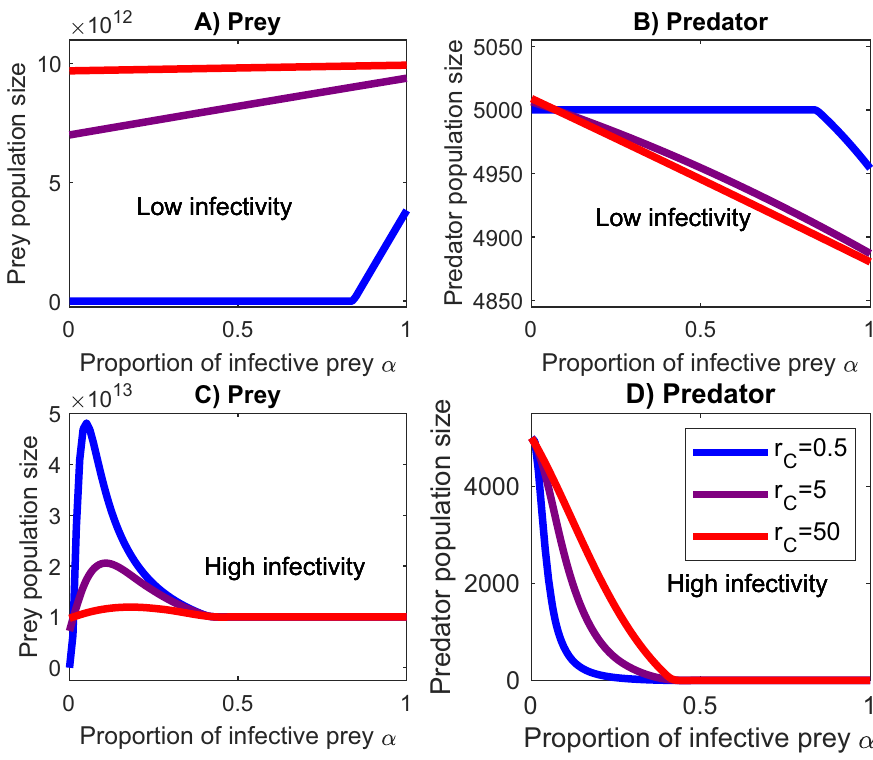
Fig 3. Proportion of infective prey α affects the population in the same way as infectivity e SI . (A) Slowly growing prey with low infectivity can proliferate only if the majority of the prey are infective. (B) Even high proportions of infective prey cause only a slight decrease in predator population. High infectivity e SI prevents the extinction of the prey. (C) Highly infective prey thrives best when it forms relatively small part of the prey population because (D) the predator becomes extinct if the majority of the prey are infective ( α ≳ 0.4). Red, purple and blue lines are fast (r C = 50), medium (r C = 5) and slow (r C = 0.5) growth rates. Infectivity values are e SI = 10 − 13 in subfigures A and B, and e SI = 10 − 11 in subfigures C and D.